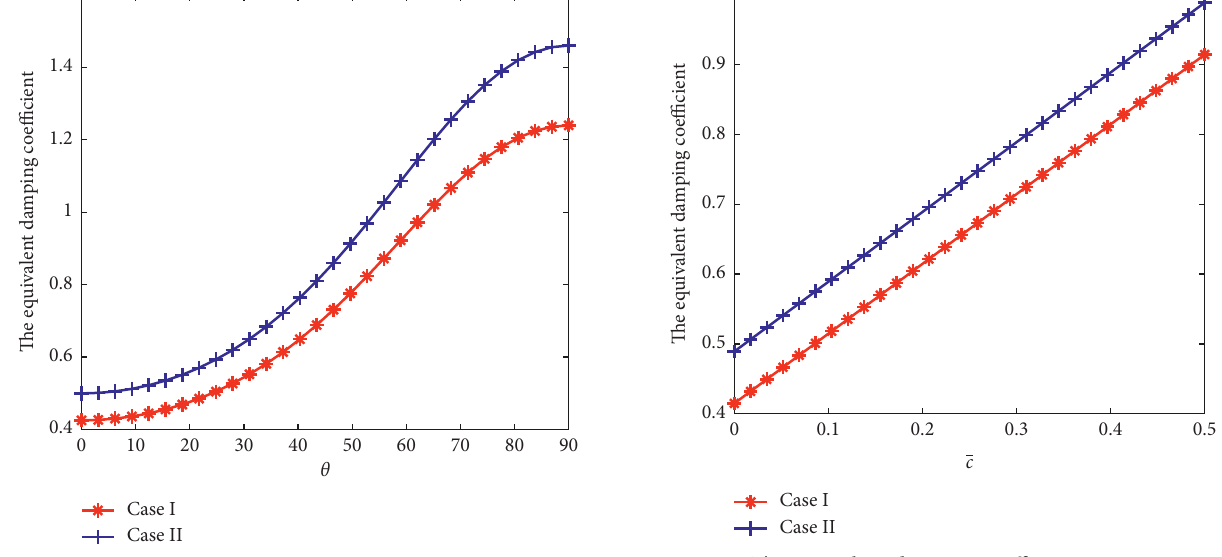
Figure 35: The equivalent damping coefficients versus ply angle for cases I and II.